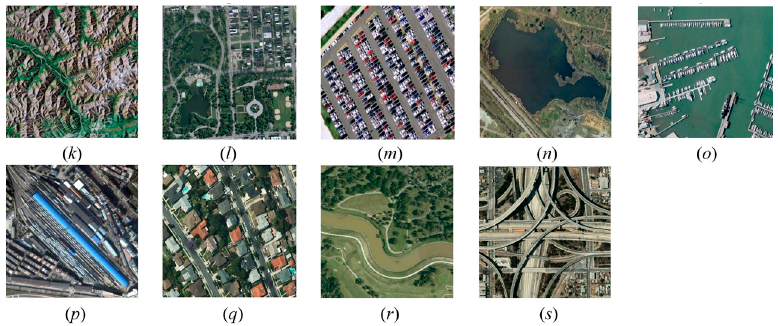
Figure 7. Representative images of the WHU-RS dataset: ( a ) airport; ( b ) beach; ( c ) bridge; ( d )